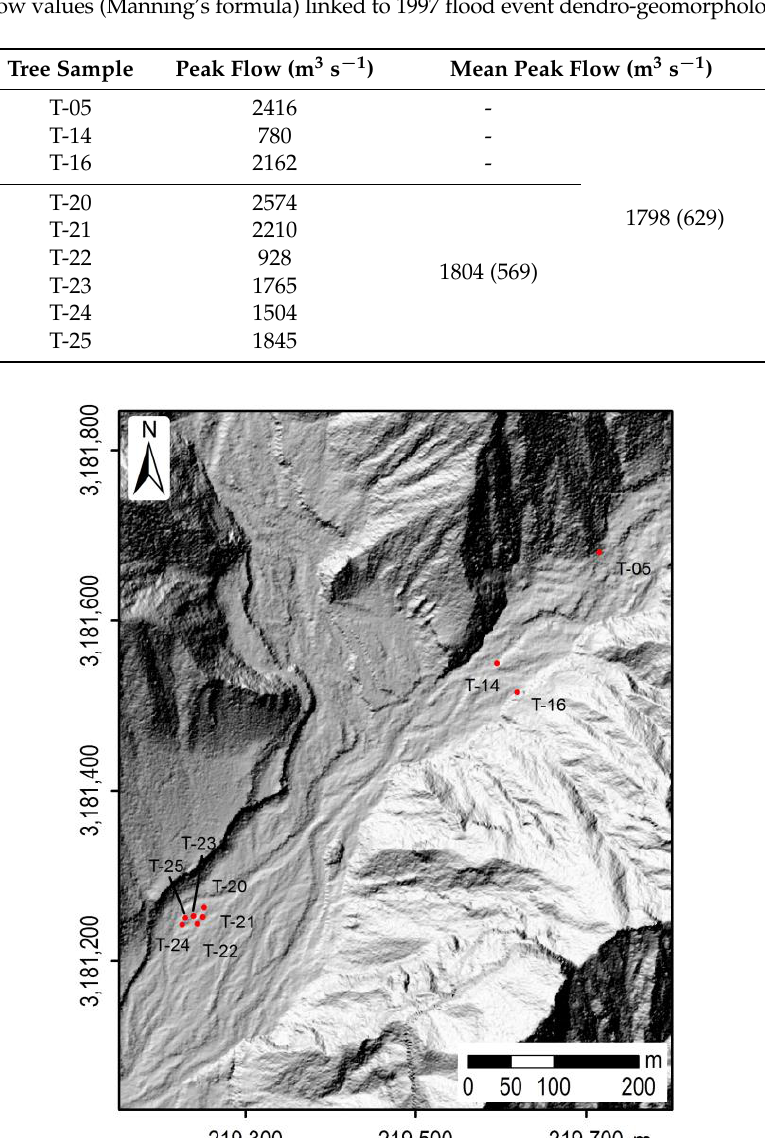
Table 4. Peak flow values (Manning’s formula) linked to 1997 flood event dendro-geomorphological evidence.